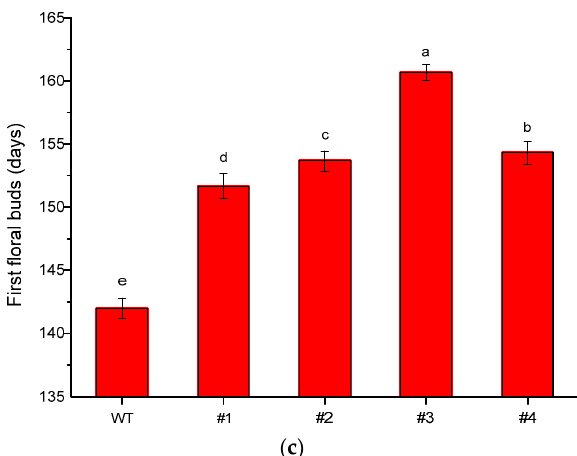
Figure 8. The flowering time of CmTFL1a transgenic chrysanthemum cultivar Jinba; ( a ) appearance of floral bud in wild chrysanthemum (upper) after 142 days in contrast with transgenic chrysanthemum (bottom); ( b ) floral bud formation after 151 and 153 days in transgenic lines #1 and #2, respectively; ( c ) floral budding period in wild chrysanthemum and in several transgenic lines. Three biological replicates were used. Error bars represent ± SD. a, b, c, d, and e are statistically significant at p ≤ 0.05 by ANOVA on ranks test.